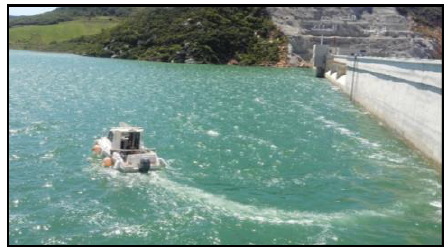
Figure 4. Galeon survey boat